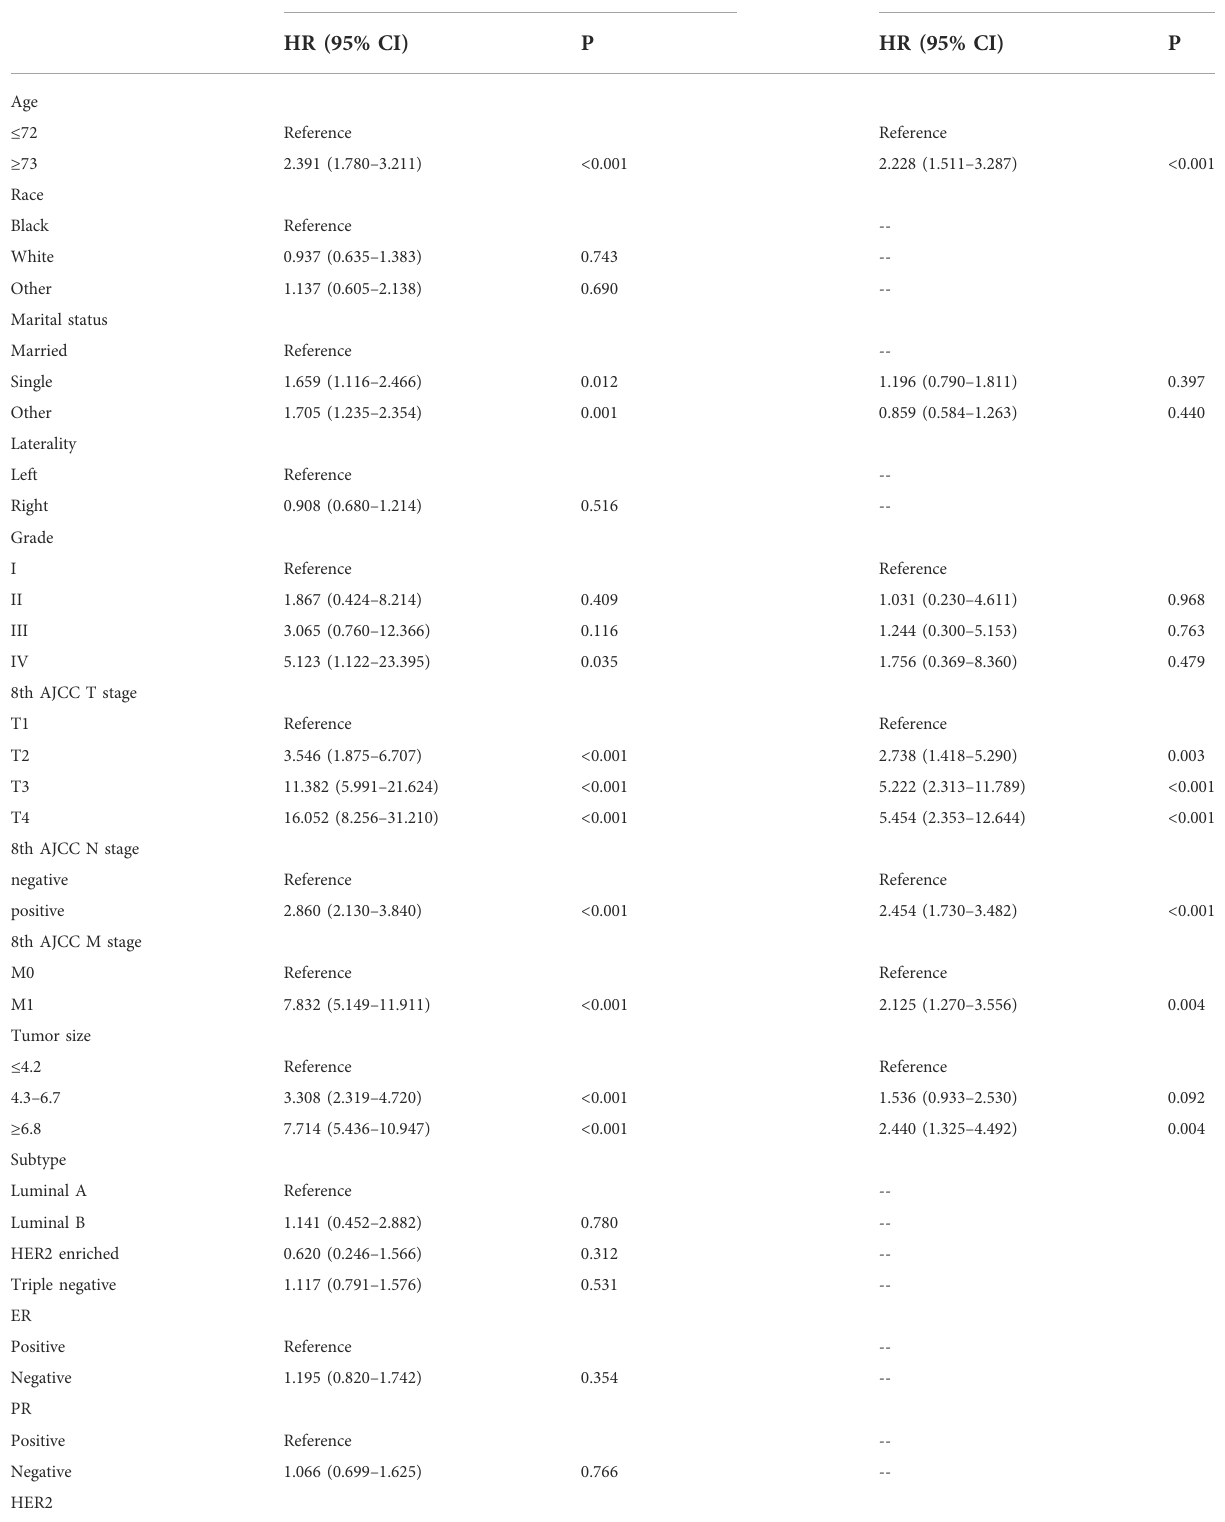
TABLE 2 Univariate and multivariate Cox regression analysis based on all variables in the training